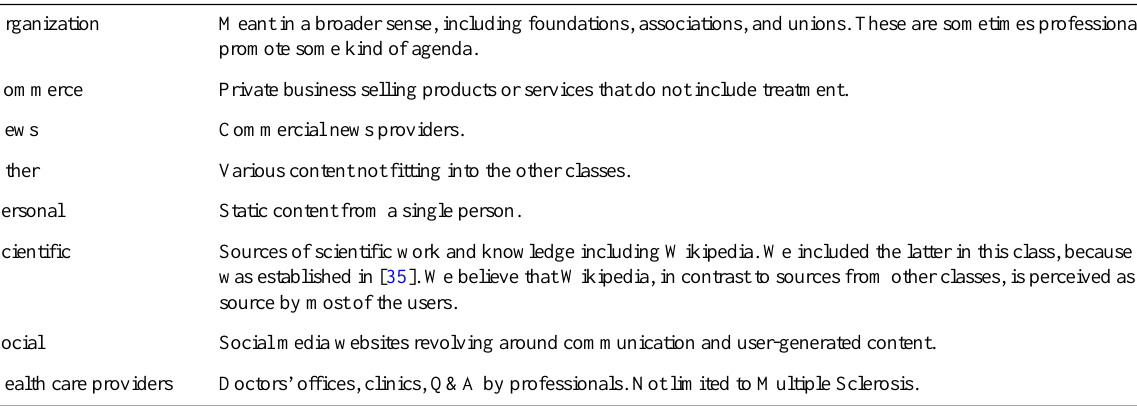
Table 1. Primary domain